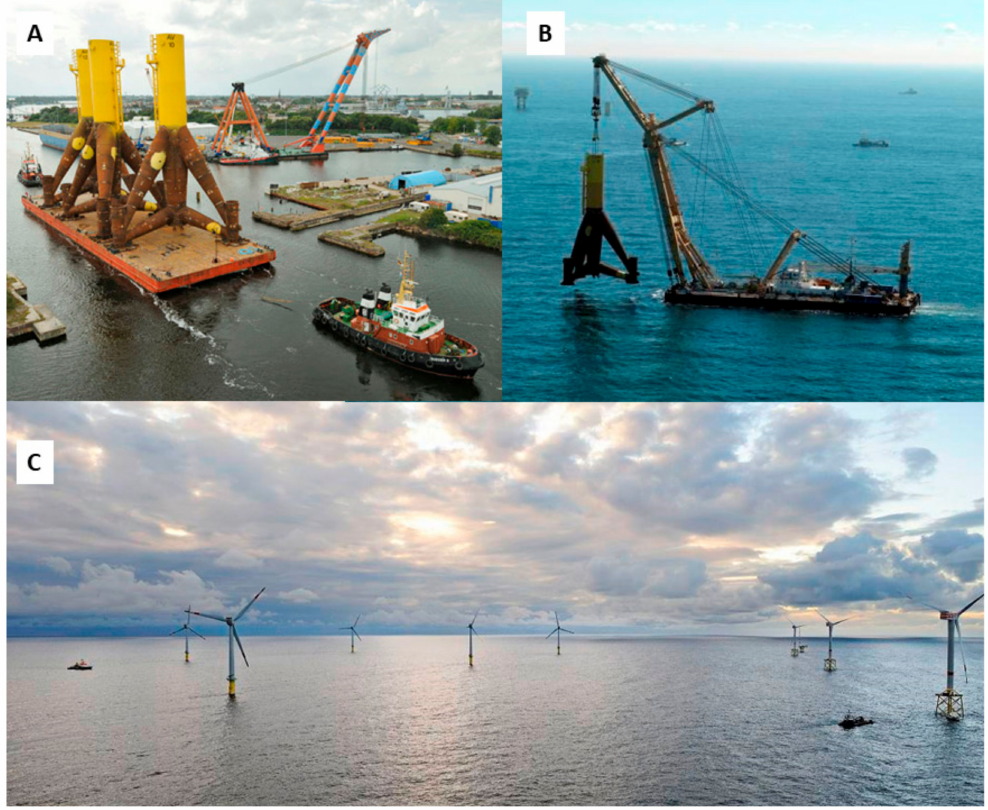
Figure 6. Alpha Ventus windfarm. ( A ) Tripod foundation transportation. ( B ) Tripod foundation installation. ( C ) Jackets (right side) and tripod (left side) foundations